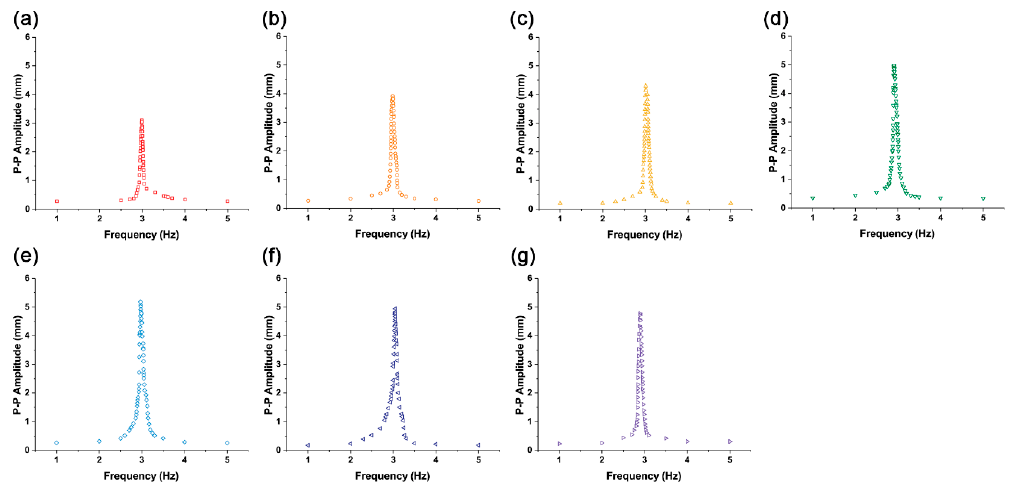
Figure 4. Frequency responses of Fe 3 O 4 -silicone composite actuators with different iron oxide concentrations. ( a ) 1%, ( b ) 1.5%, ( c ) 2%, ( d ) 2.5%, ( e ) 5%, ( f ) 10%, and ( g ) 20%.